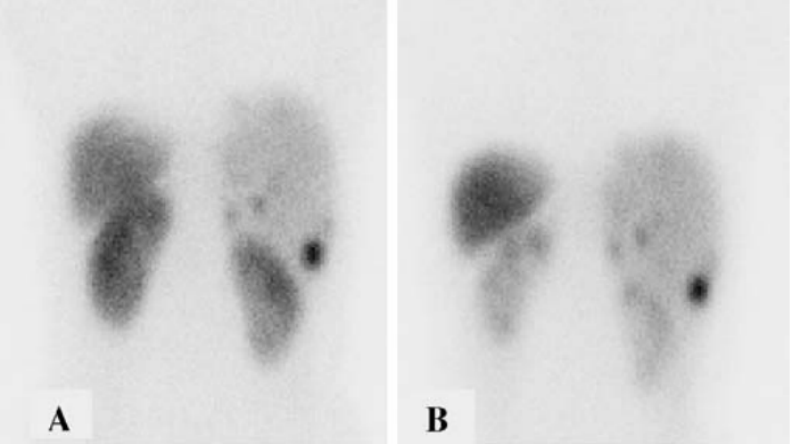
Figure 2. Abdominal scintigraphy in one patient after 220 MBq of [ 111 In]In-DTPA 0 -octreotide. The images were obtained without ( A ) and with ( B ) co-infusion of 75 g of lysine. Renal radioactivity was 59% of control when lysine was infused. Reprinted with permission from ref. [32]. Copyright 2003